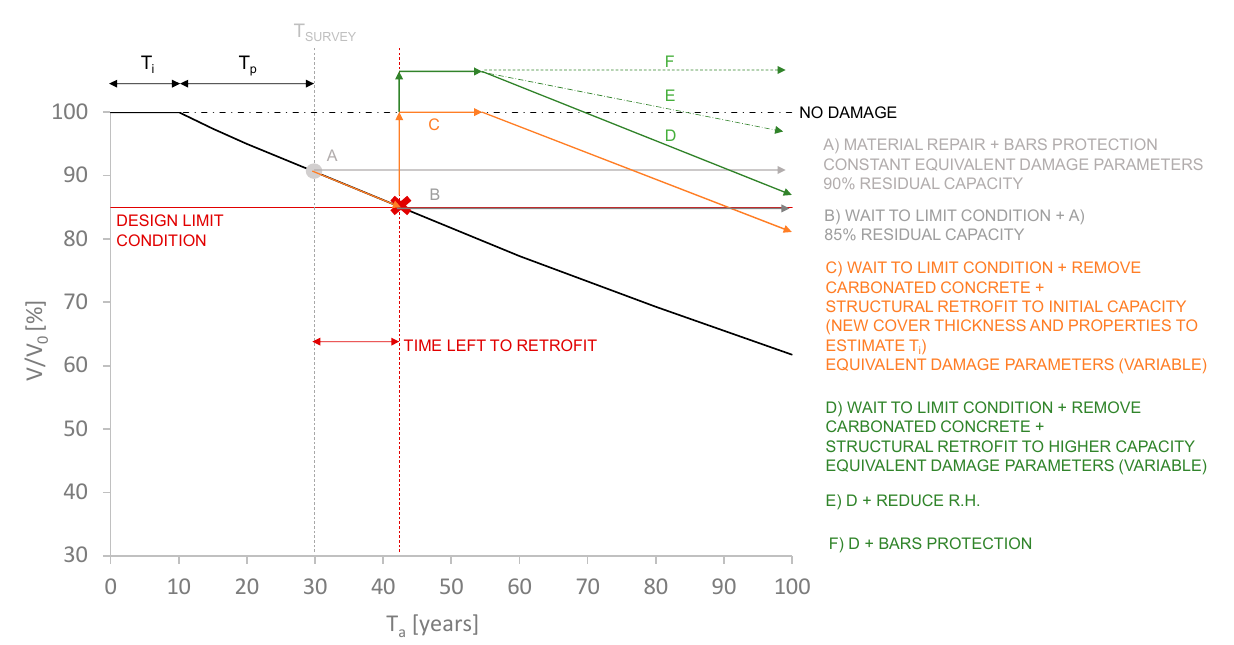
Figure 12. Example of the implementation of the predictive models in the assessment of the residual life of existing structures and in the maintenance schedule and planning.